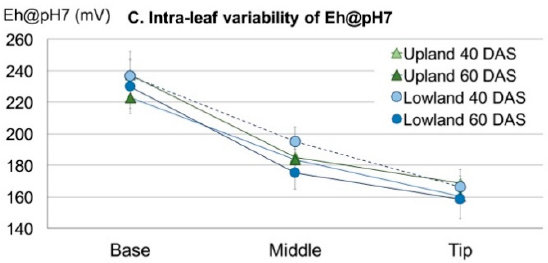
Figure 3. Intra-leaf variability of Eh (mV) ( A ), pH ( B ) and Eh@pH7 (mV) ( C ) respectively, for three leaf positions (Base, Middle, Tip), at two plant ages (40 and 59 DAS (days after sowing)), under two water management treatments (“Upland” = aerobic conditions, “Lowland” = anaerobic conditions). Error bars represent one standard deviation. Data are means of the last fully expanded leaf of the main tiller of three plants from season III, sown 13 January 2017.